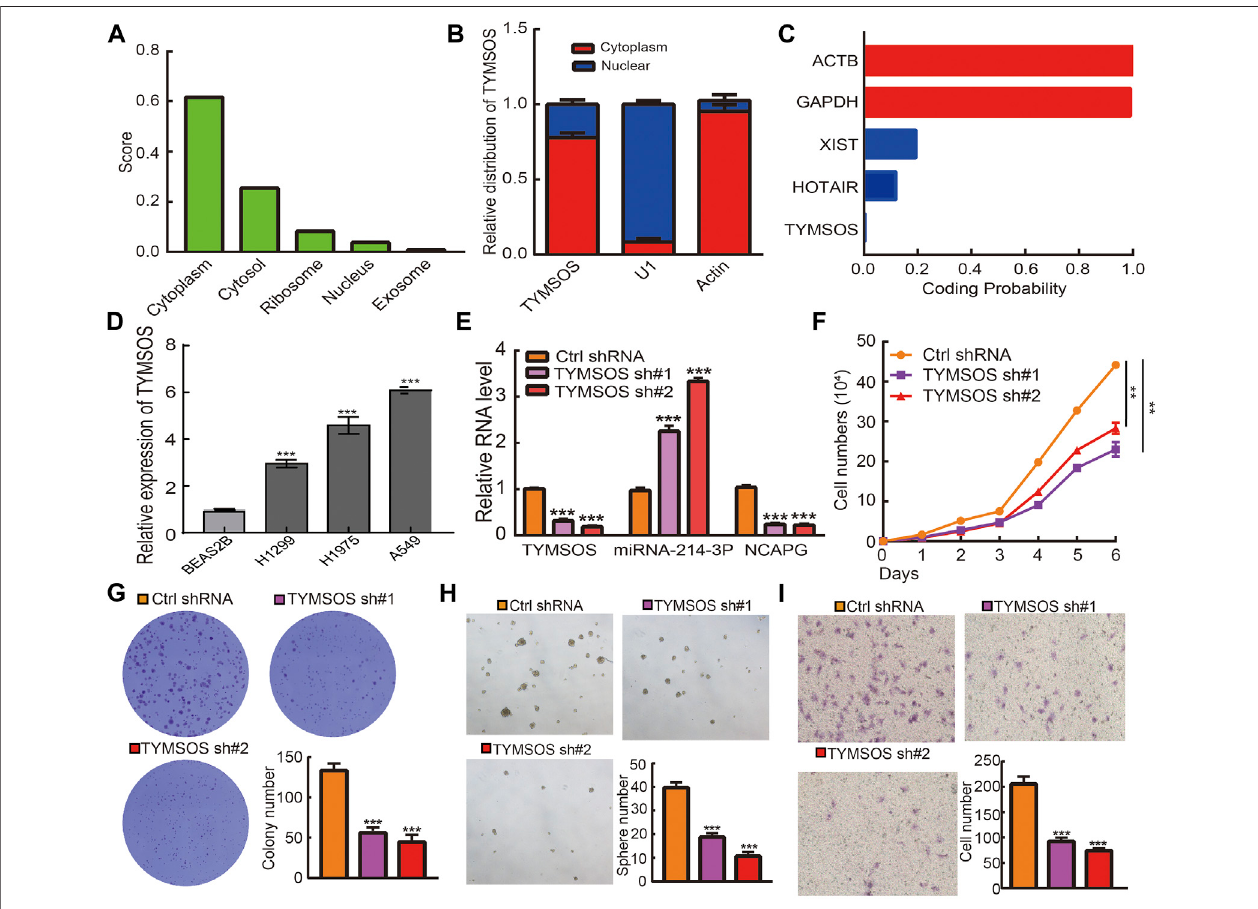
FIGURE12| TYMSOSsilencingoncellonproliferation,migration,andself-renewalabilityofNSCLCcell. (A) ThecellularlocalizationforTYMSOSwaspredictedby using lncLocator. (B) The cellular localization for TYMSOS was examined by nuclear and cytoplasmic extraction experiments. (C) The coding ability for TYMSOS was predicted by using Coding Potential Calculator. (D) The expression of TYMSOS in NSCLC cells lines was examined by qRT-PCR assay. (E) The expression of miRNA- 214-3p andNCAPG inA549cellsafter knockdown ofTYMSOS wasexaminedbyqRT-PCRassay. (F,G) Thegrowthcurve andcloneformationassayswereused to detect the silencing of TYMSOS on the growth of A549 cells. (H) The tumorsphere assay was utilized to detect silencing of TYMSOS on the self-renewal of the A549 cell. (I) The Transwell assay was utilized to detect silencing of TYMSOS on the migration of A549 cells. * p < 0.05, ** p < 0.01, *** p < 0.001.